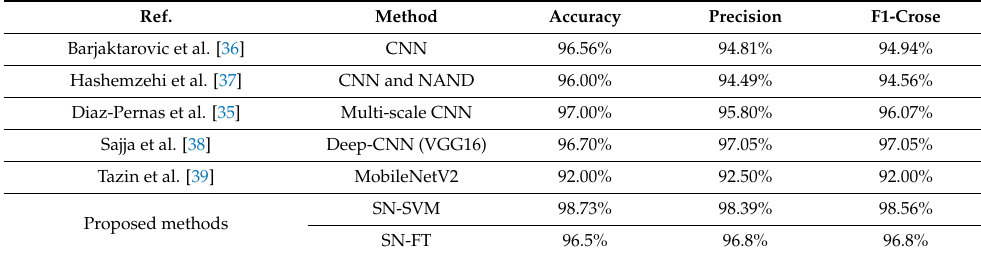
Table 5. Comparisons with the